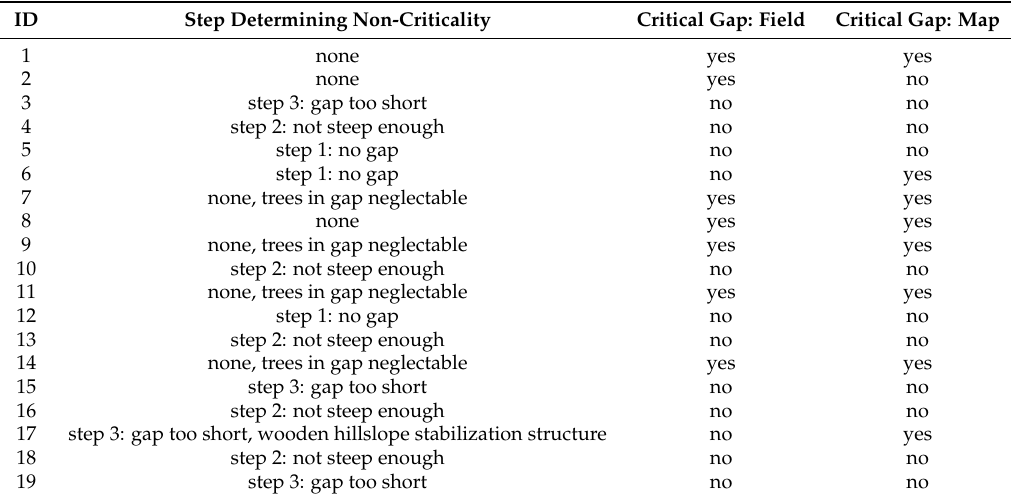
Table A1. Characterization of the 19 field samples including the steps determining non-criticality according to Table